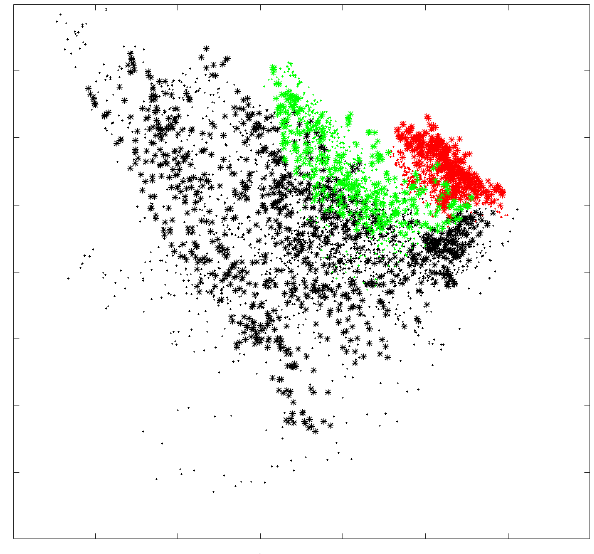
Figure 7. Mapped texture features regarding simulated samples of debris (black), vegetation (green) and gravel (red). For comparison, the clusters of Figure 3 are marked as